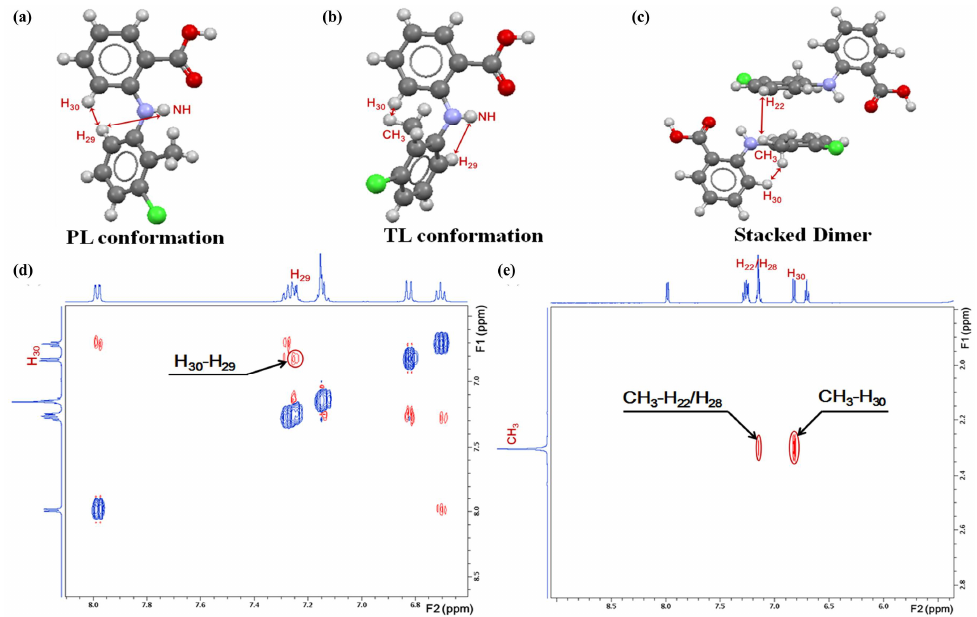
Figure 6. ( a – c ) Monomeric and dimeric structure model of TFA with selected inter-proton NOE labeled. ( d , e ) 2D NOESY spectra of TFA in ethanol-d 6 at 298 K. Positive and negative signals are represented by blue and red contours, respectively [108]. Reprinted/adapted with permission from [108]. Copyright 2017, copyright Tang, W.; Mo, H.; Zhang, M. et